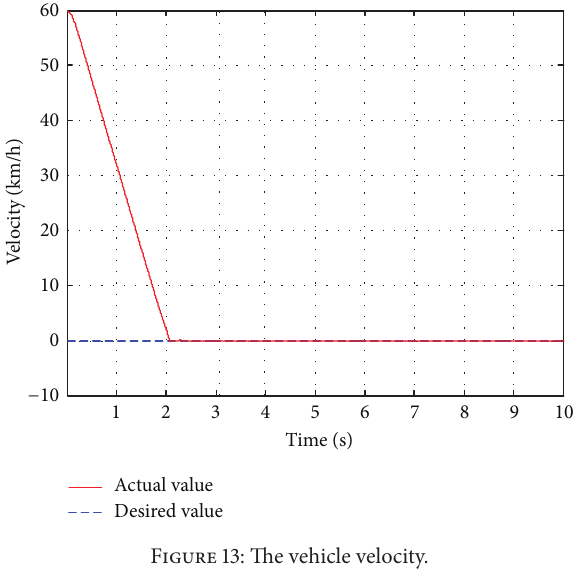
Figure 13: The vehicle velocity.